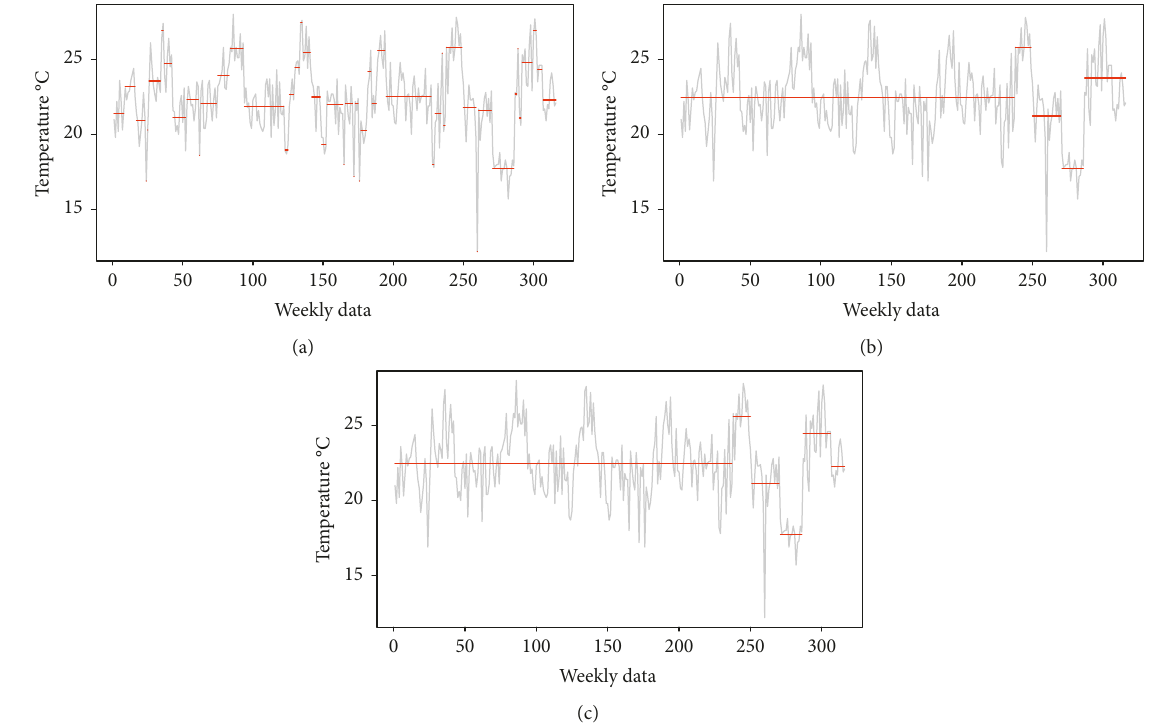
Figure 7: Location of change points for the mean of maximum temperature. (a) PELT method. (b) SN method. (c) BS method.